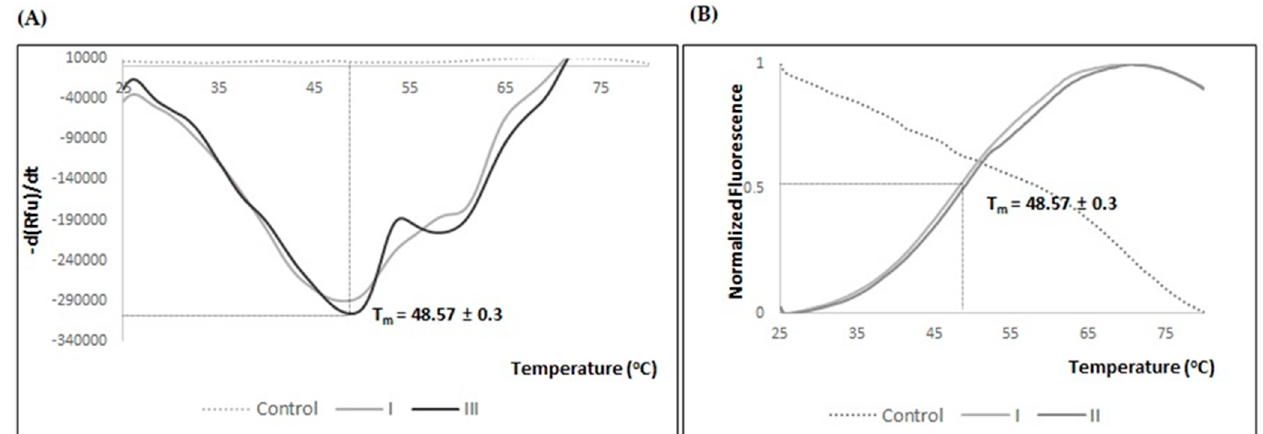
Figure 7. ( A ) TSA melting curve of hSCOMTVal108-6His from thermal stability fluorescence data of first derivate (d(Rfu)/dt) curves in 150 mM NaCl, 50 mM Tris, 1 mM MgCl 2 , 15 mM cysteine, 5 mM trehalose, 5% glycerol, and 10 mM [C 4 mim]Cl. ( B ) Normalized TSA melting curve of hSCOMTVal108-6His from thermal stability fluorescence data of first derivate (d(Rfu)/dt) curves. Control sample as 10 mM Tris-HCl pH 7.8 and 0.5 M [C 4 mim]Cl.